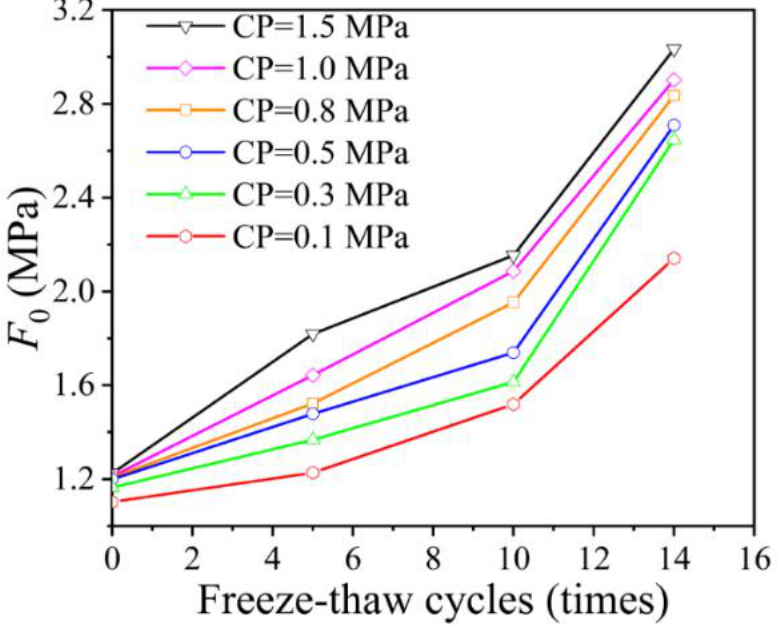
Figure 8. Effect of freeze–thaw cycles and confining pressure on F 0 . Notes: CP represents confining pressure.